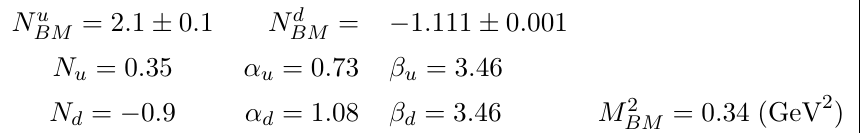
Table 4. Fitted parameters (those with error bars) and (cid:12)xed parameters (those without error bars) of the Boer-Mulders quark distributions from ref. [157].